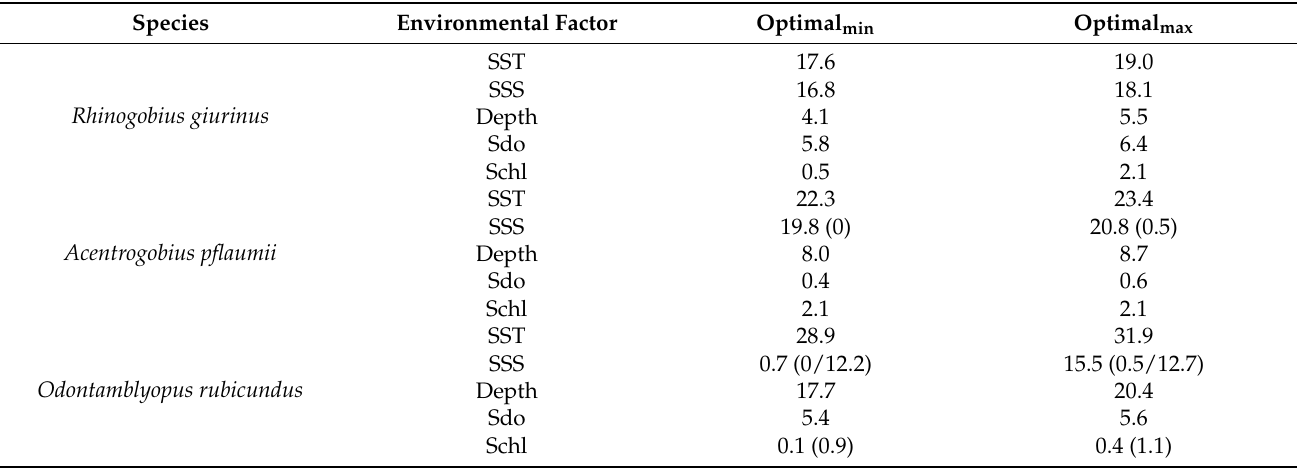
Table 2. Environmental factor ranges corresponding to the peak suitability index exceeding 0.8 for larval gobies in the Yangtze Estuary (values corresponding to more than one peak are shown in